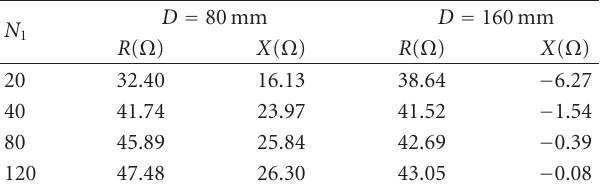
Table 2: Convergence behavior of the self-impedance result of the monopole antenna with respect to N 2 , the truncation number of the